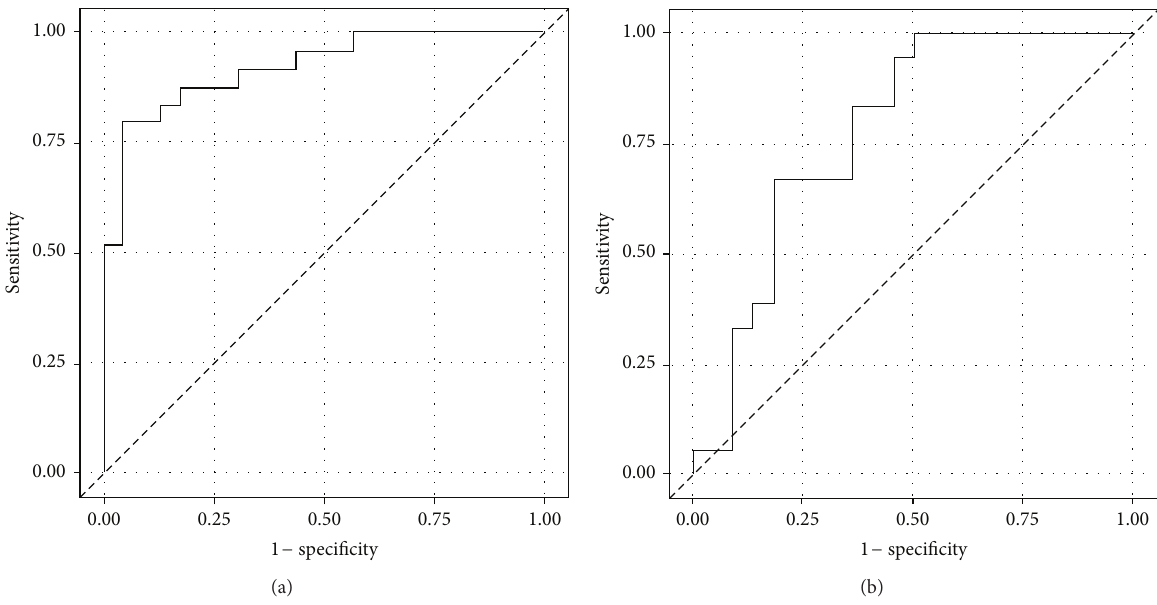
Figure 3: The internal carpal tunnel ratio (inner ratio) is plotted against the distal CSA. The squarer the carpal tunnel shape (numbers towards values of 1) and the higher the CSA value are, the more likely to have or to develop CTS. In male patients, the cutoff between patients and controls follows a distinct descending line (ROC area under the curve = 0.9235; CI 0.85 to 0.997, 𝑃 < 0.0001 ) (a). In females the cutoff line is less distinct (ROC area under the curve = 0.7778; CI 0.63 to 0.93 𝑃 = 0.0042 ) (b). 𝑅 -squared values are in male patients: 0.039 and in controls: 0.004, in female patients: 0.024 and in female controls: 0.060.